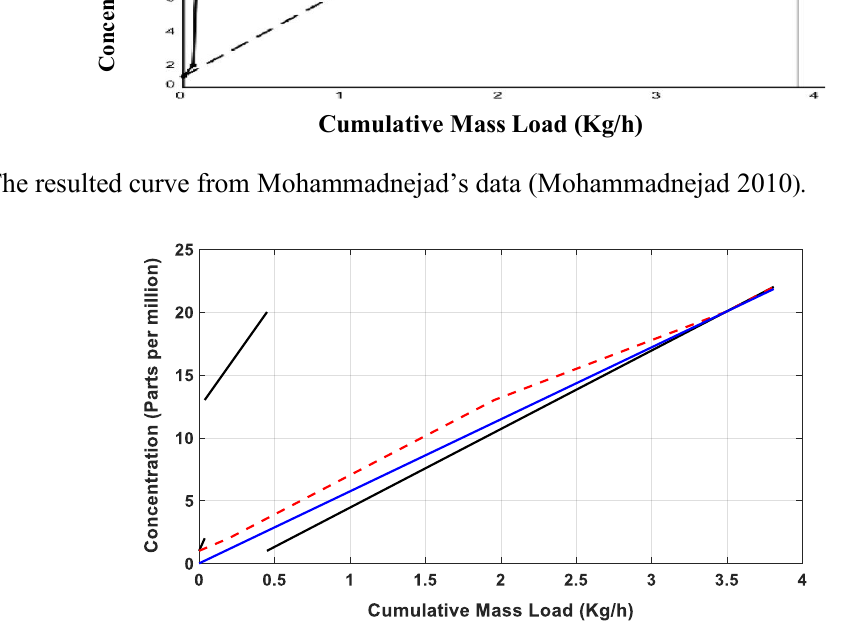
Figure6 . The resulted curve from Mohammadnejad’s data using the analyzed